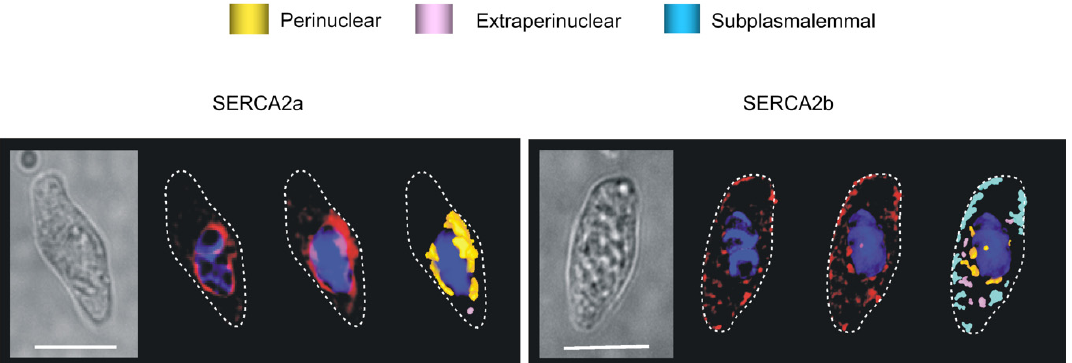
Figure 6. Example cells showing labelling for SERCA2a ( left hand series of panels) and SERCA2b ( right hand series of panels) in pulmonary arterial myocytes. In each case, from left to right, a bright field image, z section, 3D reconstruction and 3D digital representation of labelling colour coded by region of the cell are shown. Nucleus identified by DAPI labelling (navy blue). Scale bar, 10 μ m.